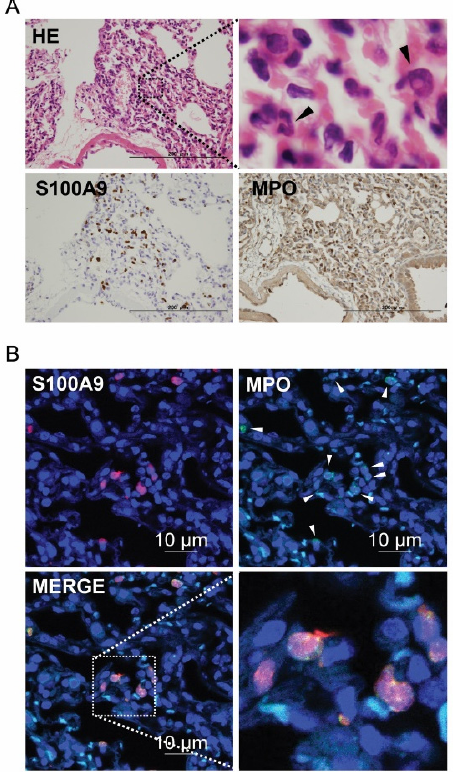
Figure 4. Localization of S100A8/A9 represented by S100A9-positive cells in the lung tissue under ischemia–reperfusion. ( A ) Hematoxylin and eosin staining and immunohistochemistry using S100A9 antibody and myeloperoxidase (MPO). Black arrowheads indicate neutrophils. ( B ) Images obtained using immunofluorescent chemistry; red indicates S100A9, green indicates MPO, and blue indicates DAPI. White arrowheads show neutrophils.